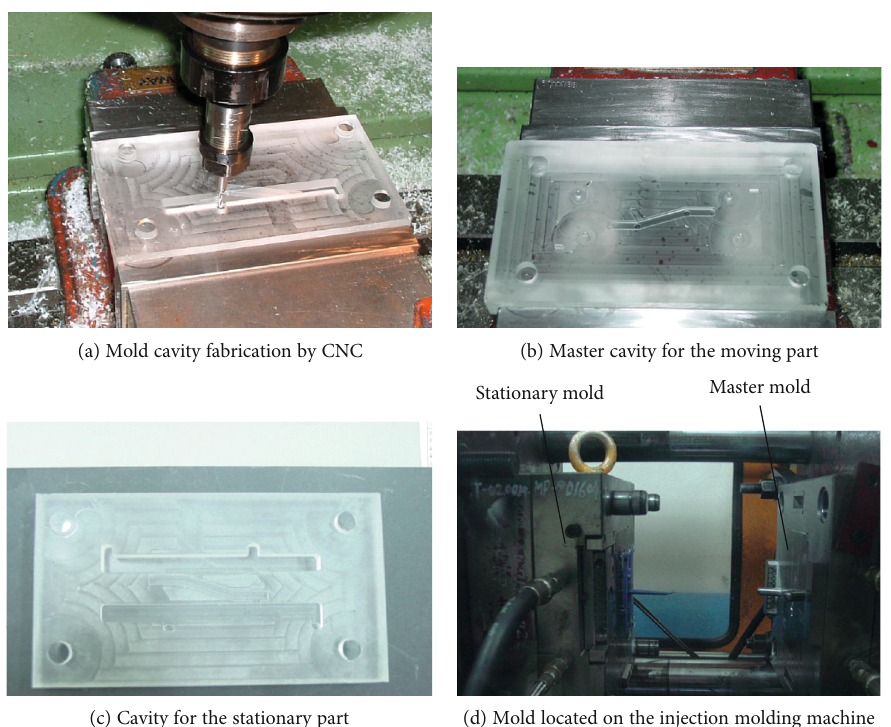
Figure 2: Fabrication of the mold cavity and the mold assembled on the injection molding